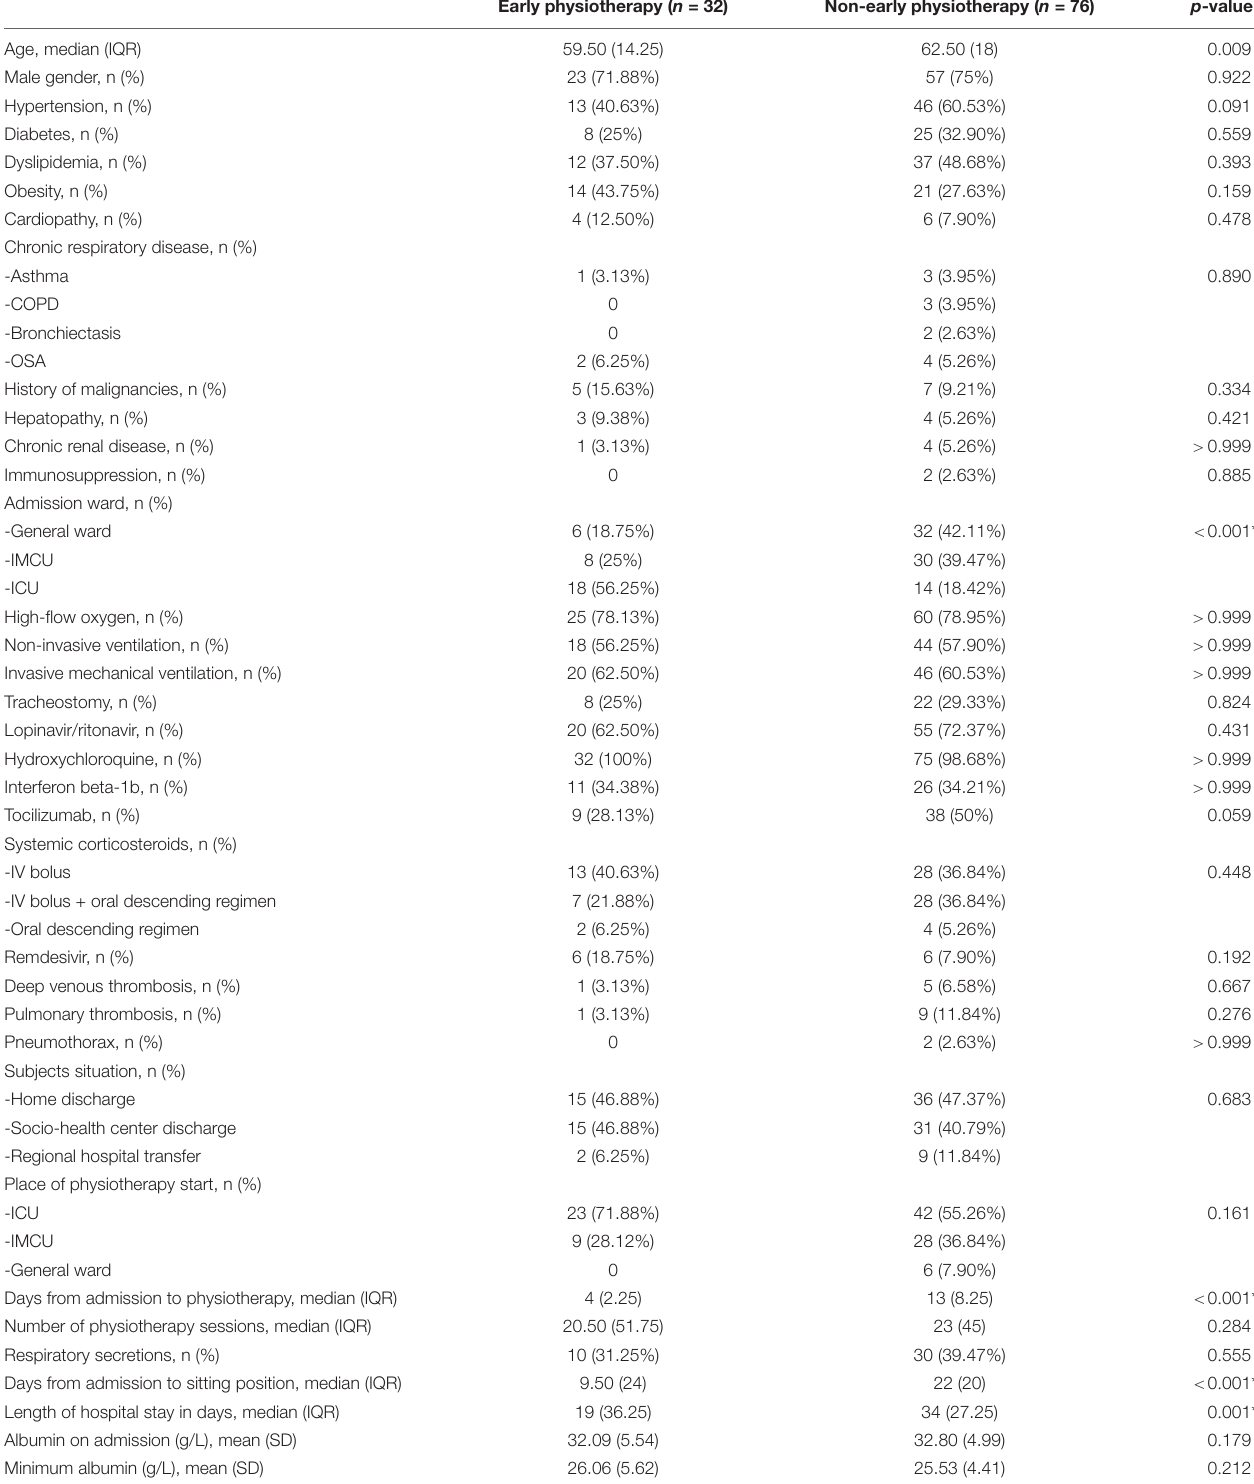
TABLE 2 | Subjects characteristics according to physiotherapy